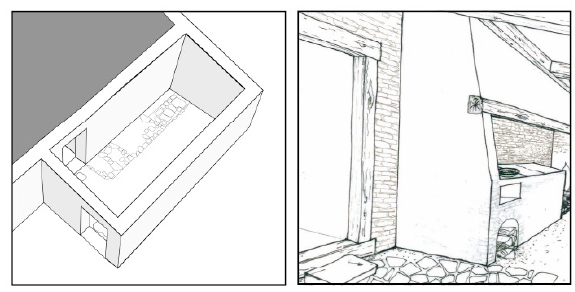
Figure 3. In-situ element reconstruction